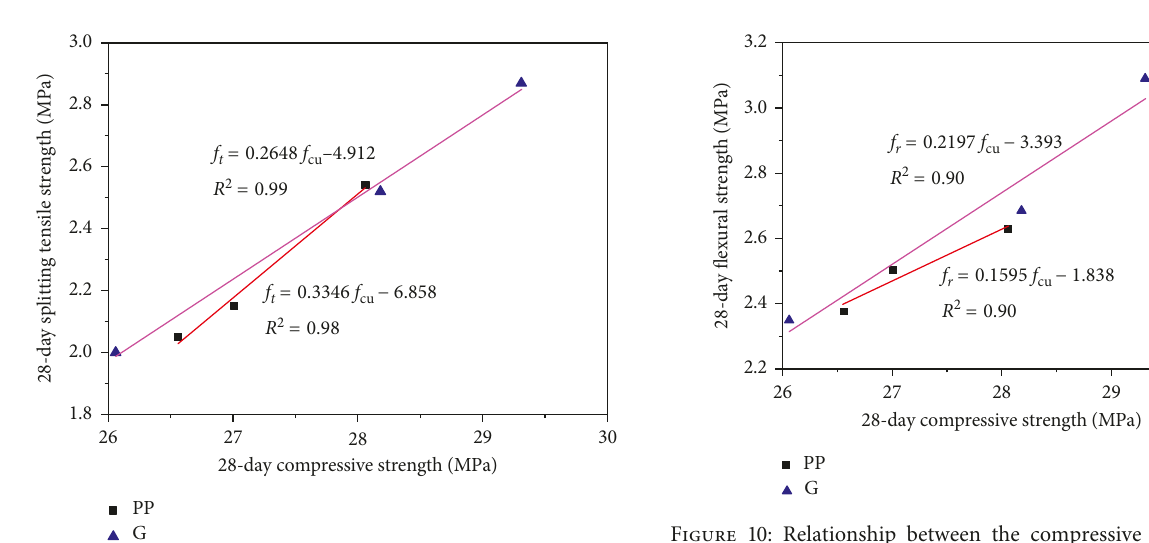
Figure 8: Specimen after the splitting tensile test: (a) control concrete without fibres and (b) concrete containing fibres.